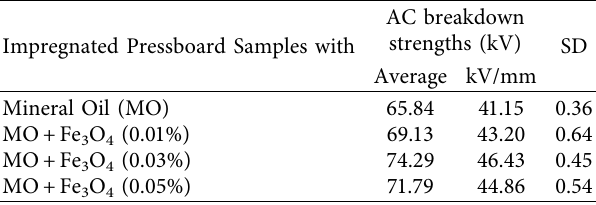
Figure 9: Comparison of the AC breakdown strengths of the impregnated pressboard. Table 5: Results of the AC breakdown strengths of the impregnated pressboard.